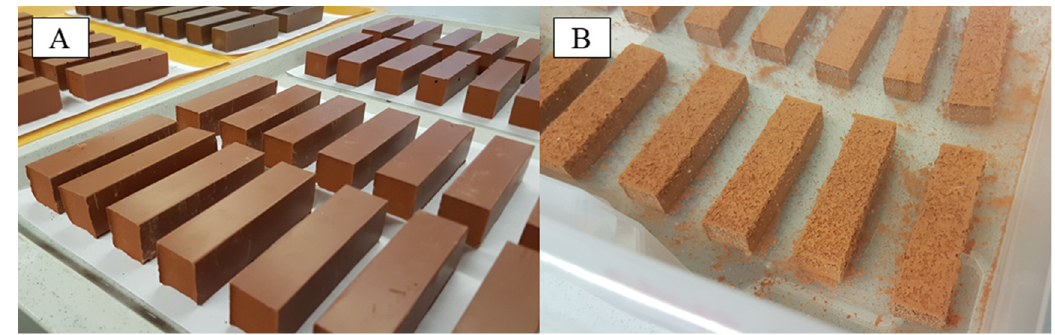
Figure 1. Geopolymer prisms MK54 (80 mm × 20 mm × 20 mm) before ( A ) and after 17 h in sulfuric acid solution (pH 1) ( B ), where the corrosion due to the erosion of the geopolymer specimen surface is already visible.